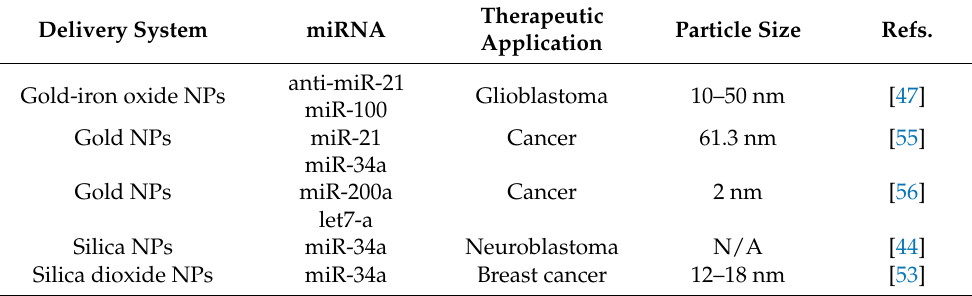
Table 1. Inorganic-based miRNA delivery